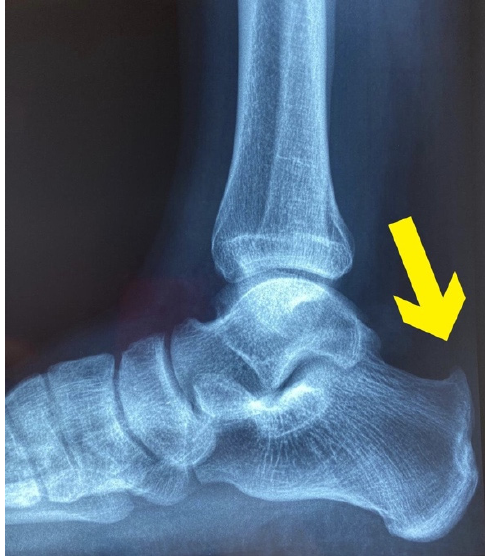
Figure 2. X-rays: The yellow arrow indicates an abnormal exostosis on the posterior superior aspect of the calcaneal bone.